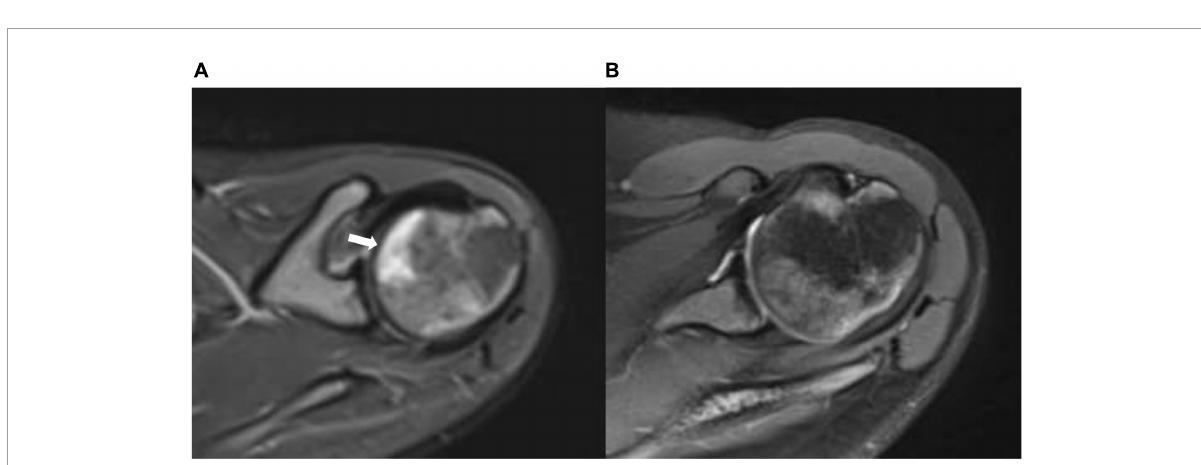
FIGURE3 (A) Axial STIR (short T1 inversion recovery) of the right shoulder before treatment with HBO showing geographic subarticular area of high-signal intensity (arrow) with no collapse of the head of the femur (stage II). (B) Axial STIR (short T1 inversion recovery) of the right shoulder after treatment showing complete resolution of the previously seen subarticular high-signal intensity suggests complete radiological resolution of avascular